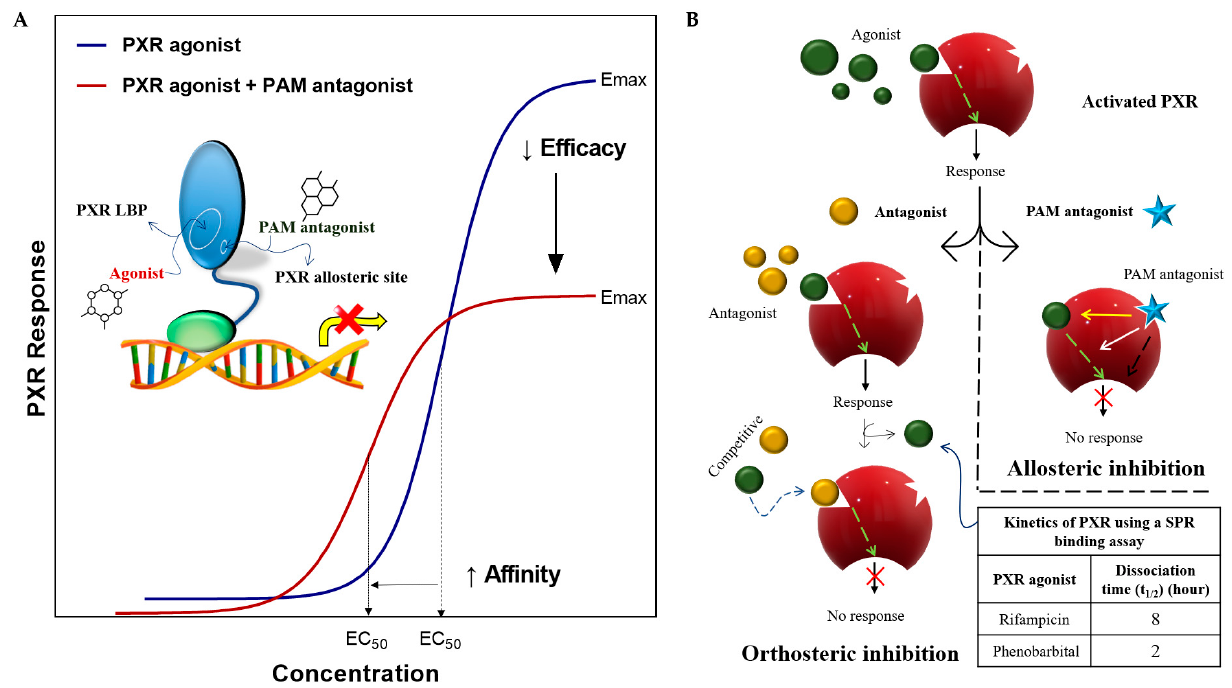
Figure 9. Mode of allosteric modulation by a PAM antagonist. ( A ) A PXR agonist dose-response curve is shown in blue, and the effect of an allosteric modulator (PAM antagonist) on the agonist effect is shown in red. A PAM antagonist decreases efficacy (E max ) and acts as an antagonist but increases the affinity of the agonist (with lower EC 50 ) for site occupancy. Agonist-activated PXRs will decrease the level of gene expression and delay the dissociation of the PXR agonist through the PXR PAM antagonist [63,110] . ( B ) Orthosteric antagonist versus allosteric PAM antagonist receptor mechanisms in an agonist-activated receptor. Orthosteric antagonist: the antagonist (yellow) competes with the agonist (green) to occupy the orthosteric site and/or wait for the dissociation of the agonist from the receptor (e.g., rifampicin dissociation rate (t 1/2 ) is 8 h) [111] . Allosteric PAM antagonist: The PAM antagonist directly binds to its distinct site of the receptor and initiates its antagonist function. At the same time, this increases the affinity of the agonist to prevent its dissociation [63] . EC 50 represents the concentration of a drug that induces a half-maximal response.